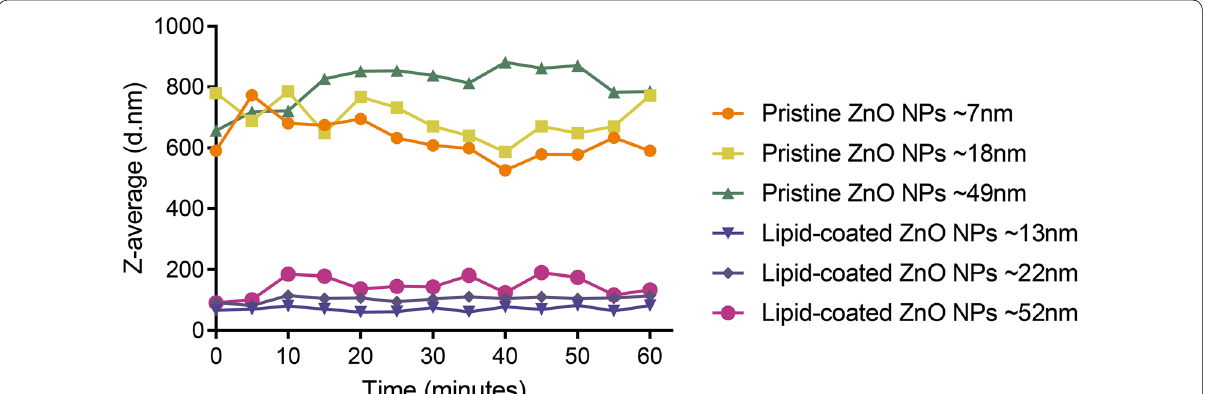
Fig. 7 The DLS analysis of pristine ZnO NPs and lipid-coated ZnO NPs in terms of mean hydrodynamic size (Z-average) in water solution from 0 to 60